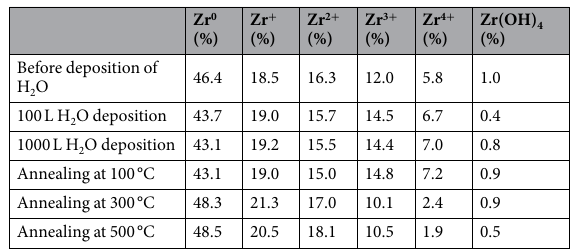
Table 1. Relative proportions of the zirconium species in ZIRLO calculated from each peak integral of the peak fitting results of Zr 3 d HRPES spectra in Fig.